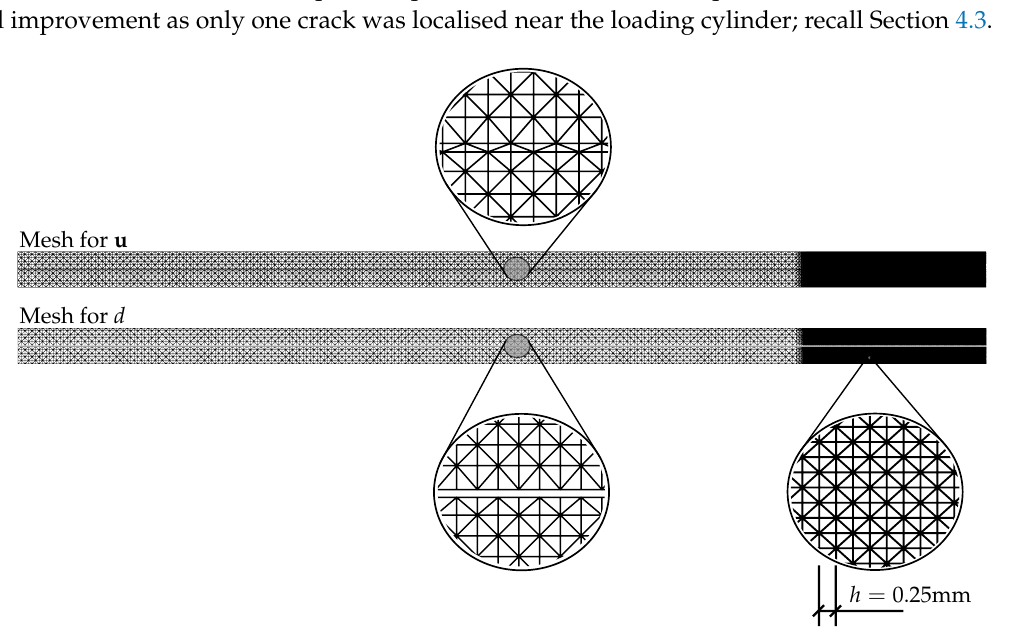
Figure 15. Locally refined discretization for the 2D laminated glass plane-stress model. Phase-field variable d is calculated on the sub-mesh in both glass layers